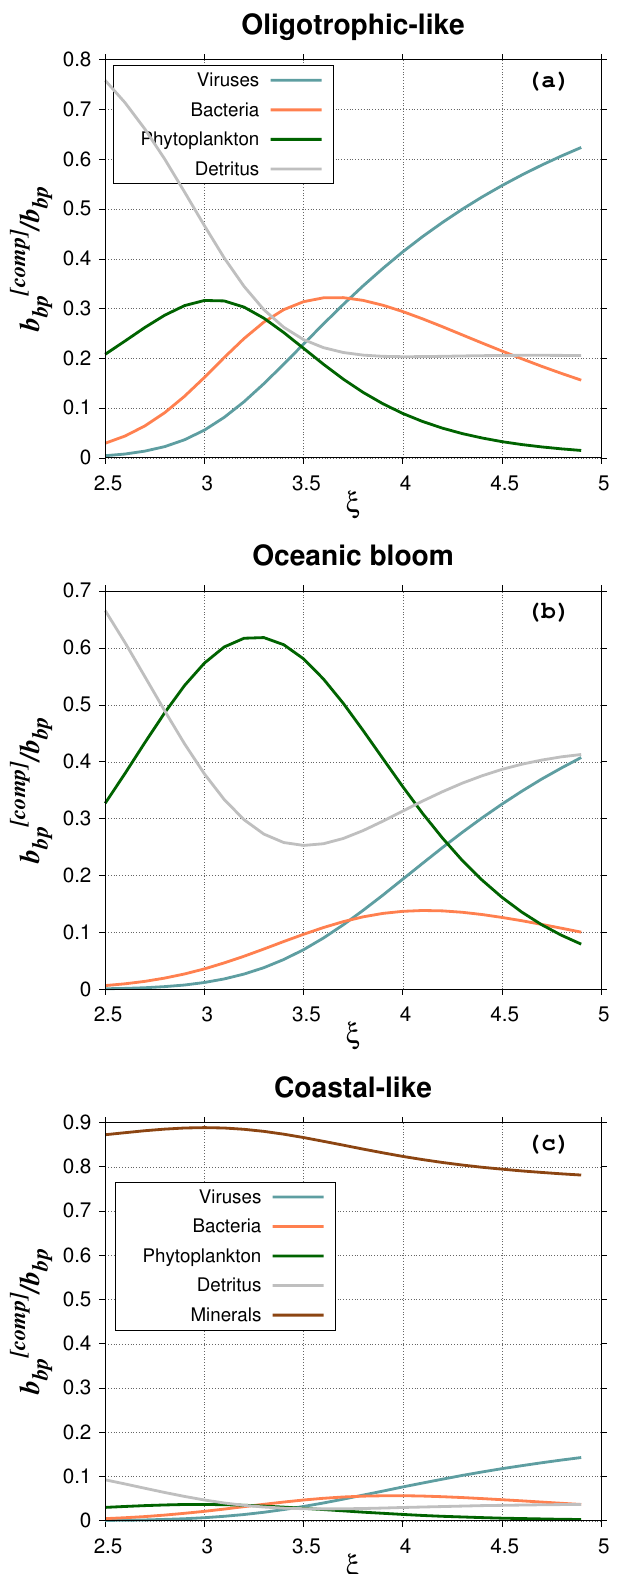
Figure 8. Contribution of the different particle groups the total bulk backscattering ratio for ( a ) oligotrophic-like, ( b ) phytoplankton bloom, and ( c ) coastal-like water bodies. The phytoplankton cells are modeled as a two-layered sphere